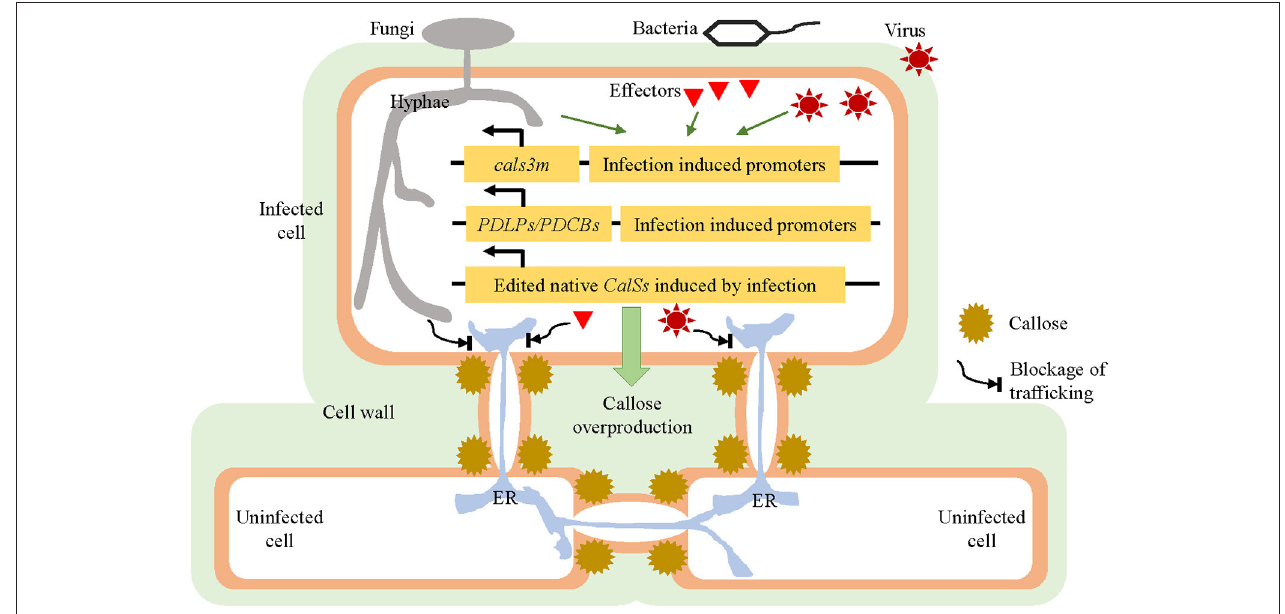
FIGURE 2 | Strategies for improving the disease resistance of hosts by modulating their plasmodesmata (PD). Under normal plant growing conditions, the cals3m , PDLPs/PDCBs , and edited CalSs genes are expressed at a relatively low level, without affecting the plants’ ordinary development. Once a pathogen attack is detected, the expression of cals3m , PDLPs/PDCBs , and edited CalSs could be induced quickly and strongly, resulting in prompt callose overproduction around the PD and PD closure; this is followed by imposing a blockage of connections between the primary invaded cells and neighboring uninfected cells, which should also stop the intercellular trafficking of pathogens or effectors. These hypothesized approaches are supposed to slow down the spread of pathogens and thus enhance the disease resistance of host plants. PD, plasmodesmata; CalS, callose synthase; PDLP, PD-Localized Protein; PDCB, Plasmodesmata Callose-Binding